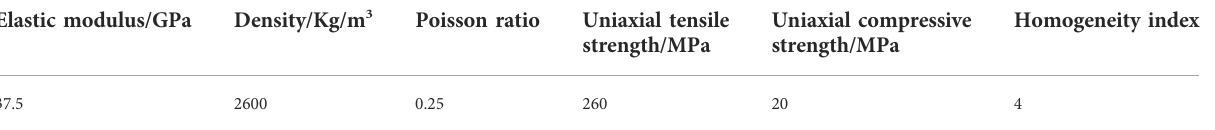
TABLE 1 Mechanical